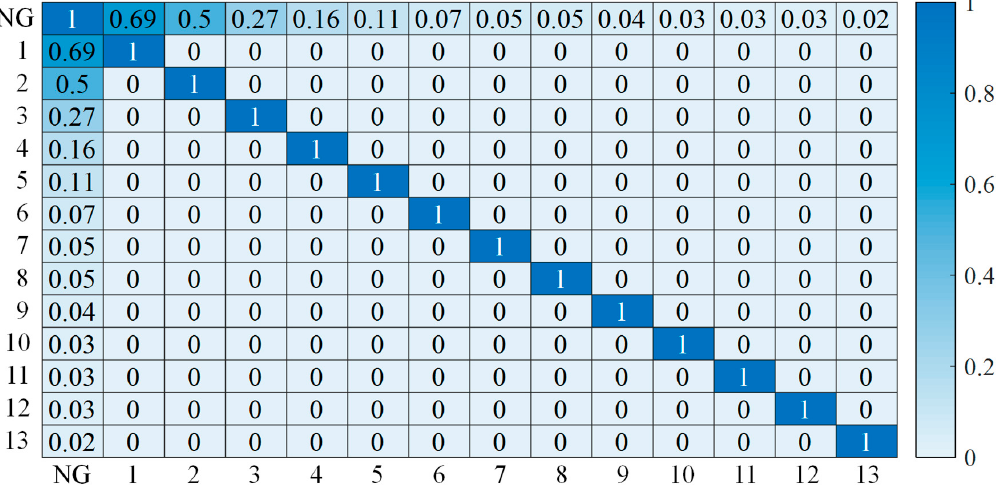
Figure 8. The components obtained by PCCA (Xi’an case).